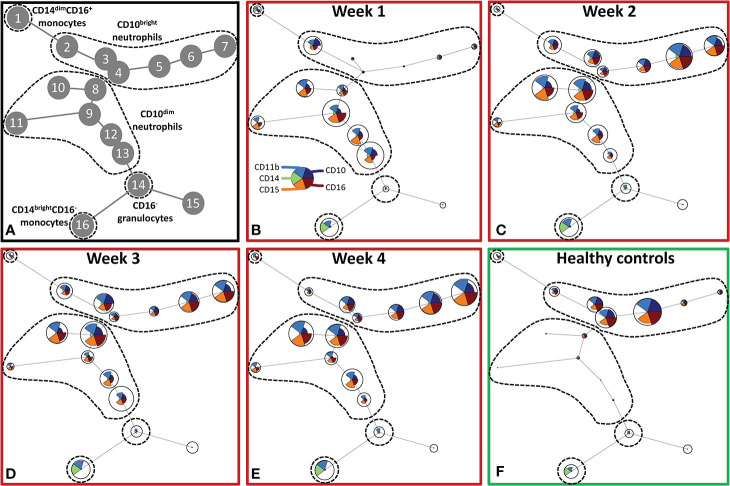
Unsupervised FlowSOM analysis of granulocyte and monocyte subtypes after severe burn injury. FlowSOM plots present proportions of populations and the expression of markers that were used in the innate flow cytometry panel (CD10, CD11b, CD14, CD15 and CD16). (A) Cluster structure based on flow cytometry data of 10 healthy controls and 7 burn wound patients that were observed for 4 weeks. The most pronounced subtypes are encircled by dashed lines: CD16+ monocytes (node 1), CD10bright neutrophils (nodes 2-7), CD10dim neutrophils (nodes 8-13), CD16- granulocytes (node 14), CD14dim- CD14brightCD16- monocytes (node 16). FlowSOM plots of: (B) Week 1; (C) Week 2; (D) Week 3; (E) Week 4 after burn; (F) Healthy controls.